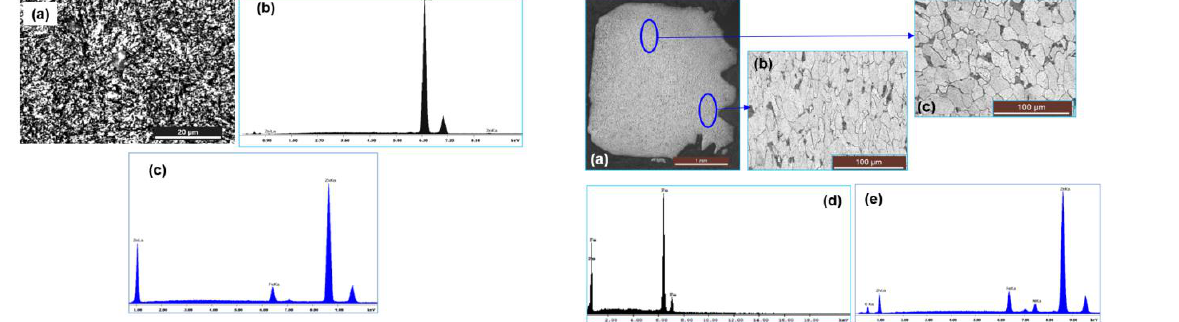
Figure 13: (a) Cross-sectional etched optical micrograph of the spring washer, etchant: 5% nital, (b) EDS analysis of the base material for spring washer, (c) EDS analysis of the coating for spring washer.